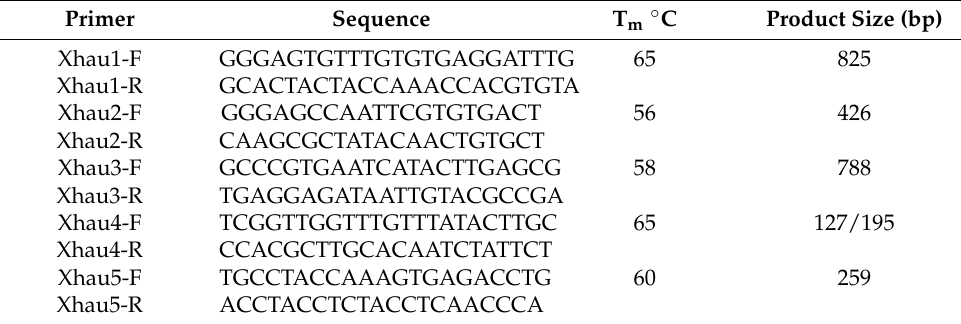
Table 6. Primers used in the study for the identification of allelic variations at TaHST1 associated with HST in synthetic wheat. Primer